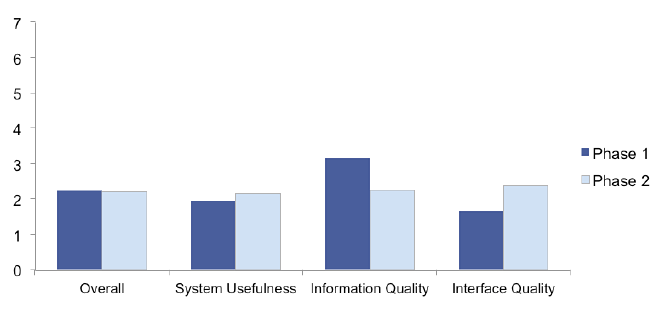
Figure 2. Comparison of mean PSSUQ scores across categories for phase 1 and phase 2 data. Note: Lower scores indicate higher levels of usability and